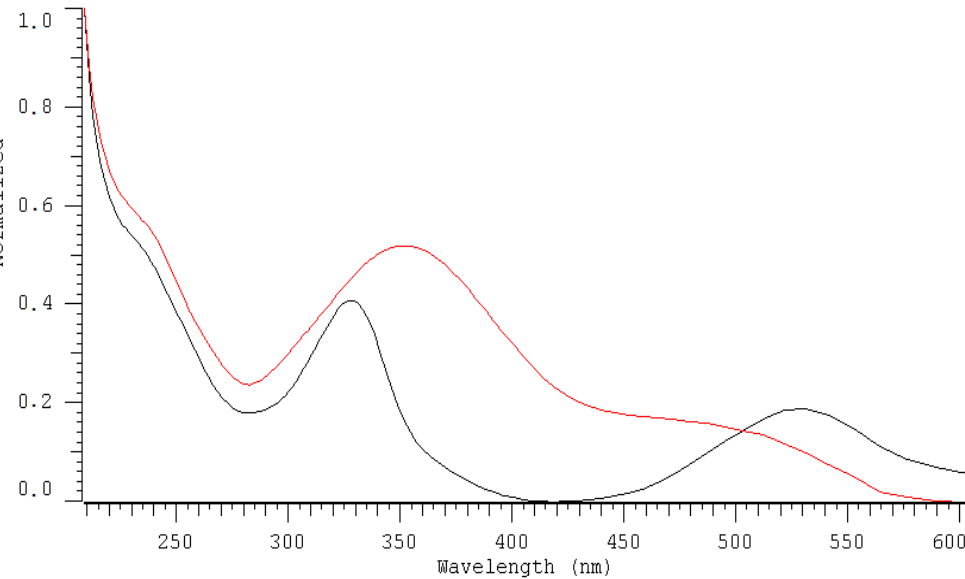
Figure 2. Recorded spectra in the range of 200–600 nm for DPPH • (DPPH-R-black line) and DPPH-H (red line) at 3.98 min and 2.97 min, respectively.